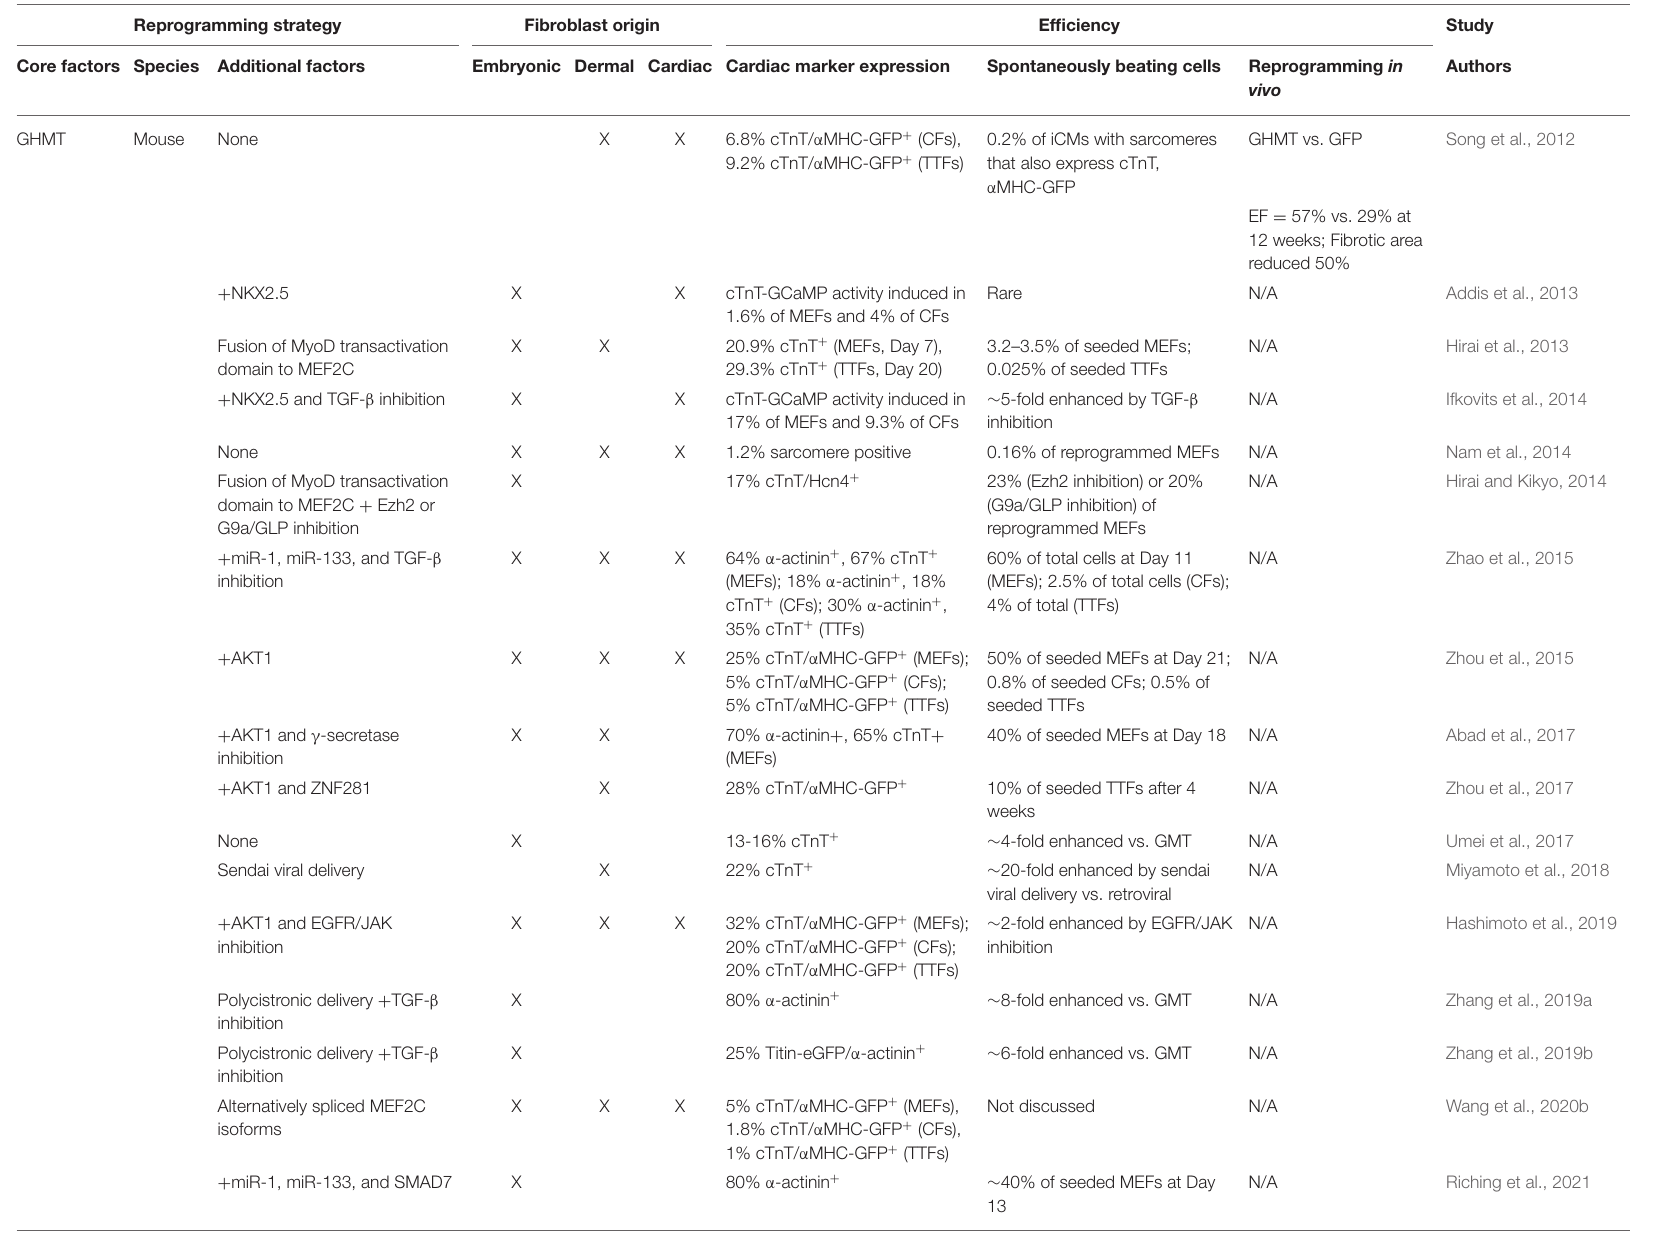
TABLE 2 | In vitro and in vivo efficiencies of GHMT-based reprogramming